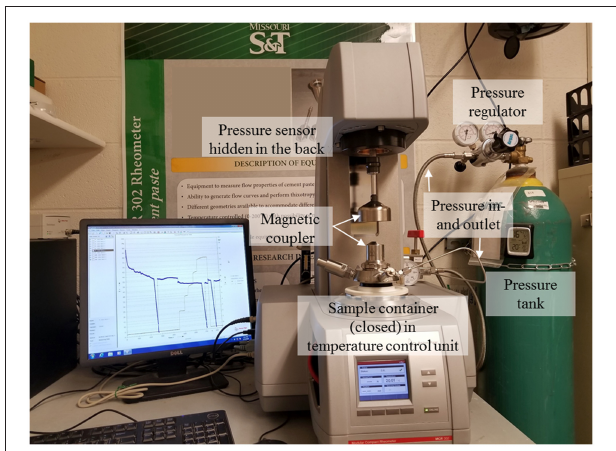
FIGURE 1 | Set-up of rheometer with pressure system in Anton Paar MCR 302.